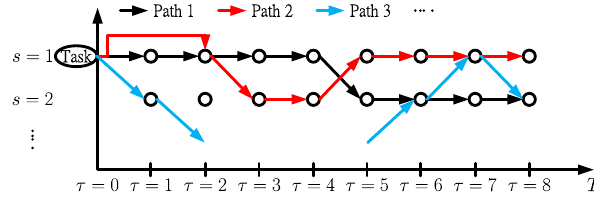
Figure 6. Tree structure of the SP .